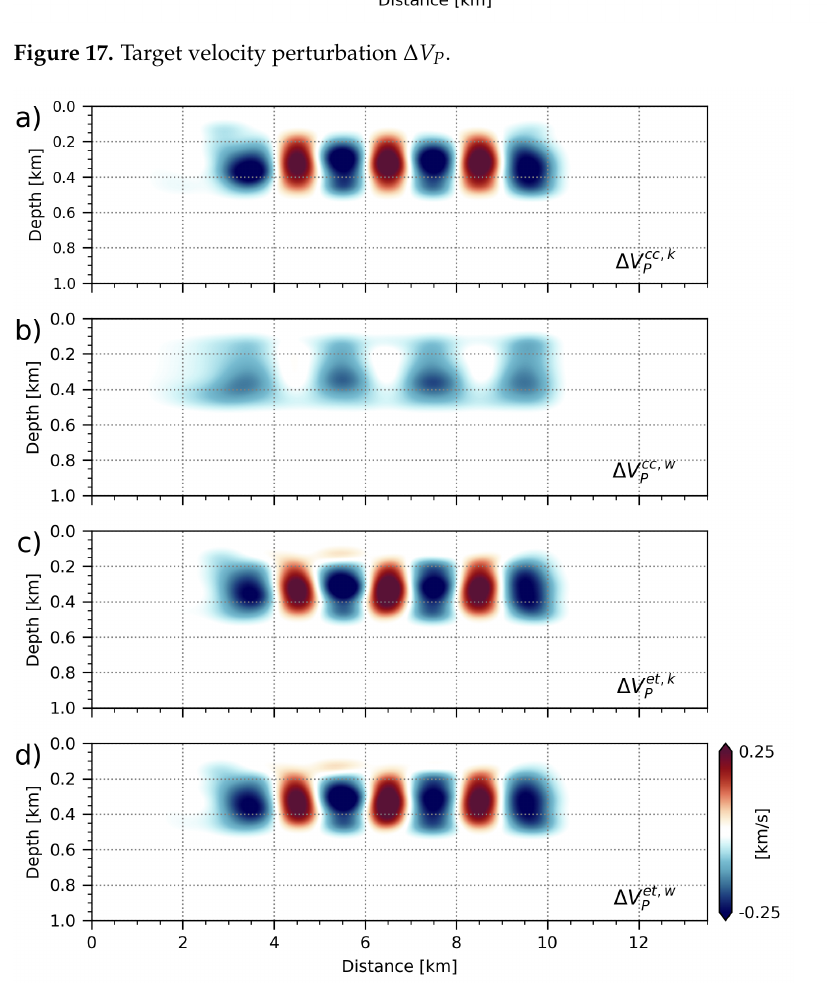
Figure 18. ( a , b ) are the recovered perturbations ∆ V cc , k function with correct and wrong source wavelets; ( c , d ) are the recovered perturbations ∆ V et , k ∆ V et , w by the ET objective function with correct and wrong source P